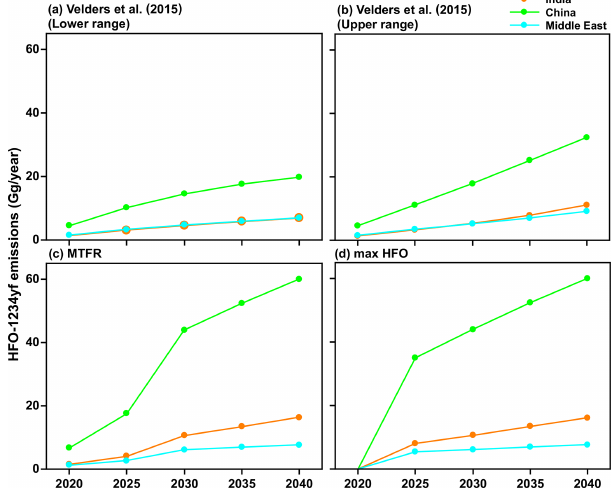
Figure 2. The projected HFO-1234yf emissions scenarios between 2020 and 2040 from Velders et al. (2015). (a) Lower and (b) up- per ranges. International Institute for Applied Systems Analysis (IIASA) GAINS model for (c) maximum technically feasible re- duction (MTFR) and (d) max HFO in India, China, and the Middle